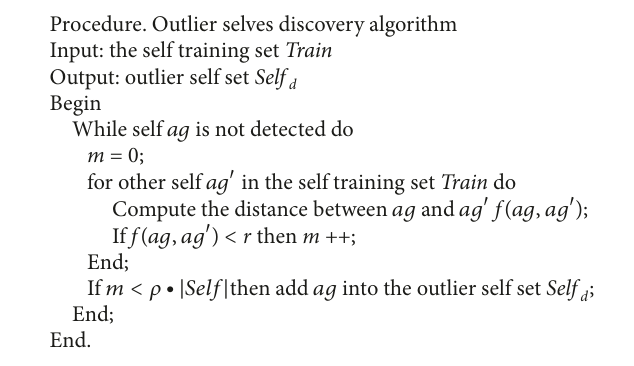
Algorithm 4: The process of outlier selves discovery